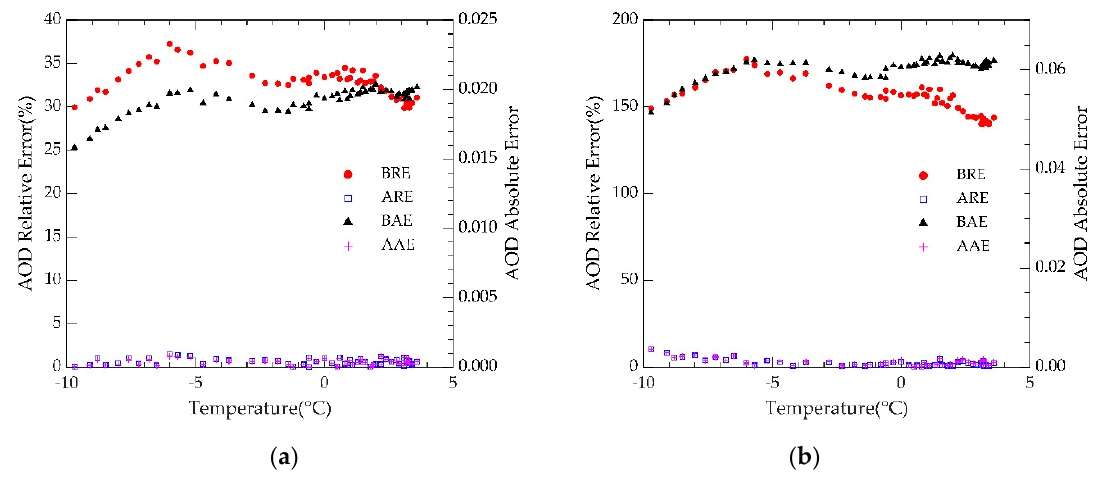
Figure 4. RE and AE of the estimated AOD and the theoretical AOD varying with temperature ( ℃ )